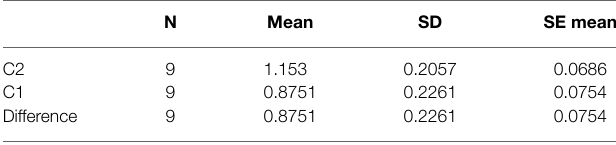
TABLE 10 | An example of pair t -test: C2-C1 .